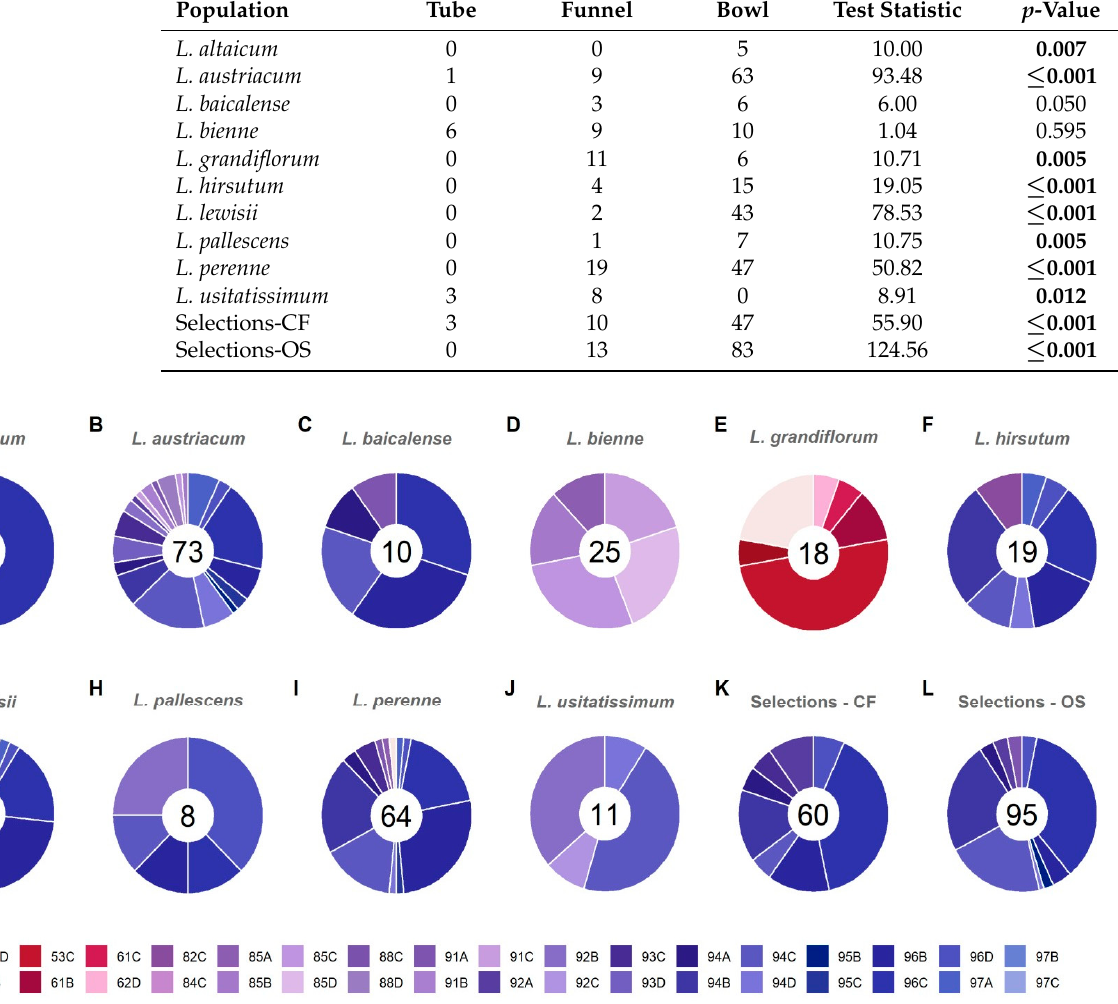
Table 4. Chi-square tests (1:1:1; test statistics, p -values, df = 2) for flax flower shapes in all populations and CF and OS selections tested. Flower shapes are classified as tube, funnel, or bowl [17]. Counts represent the number of individual plants within each category of plant shape. p -values of α ≤ 0.05 are highlighted in bold.